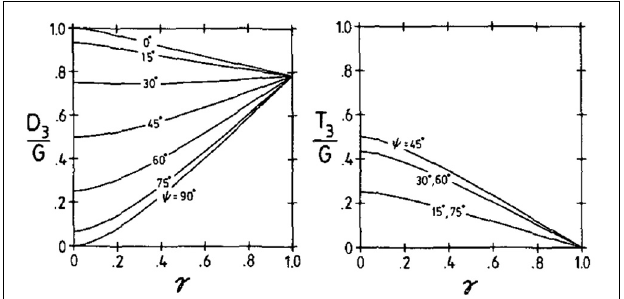
FIGURE 2 | Normalized drag components parallel ( D 3 ) and perpendicular ( T 3 ) to the incoming wind as a function of ψ and γ (see curve labels for details). Reproduced from Figure 8 of Phillips [51]. © American Meteorological Society. Used with